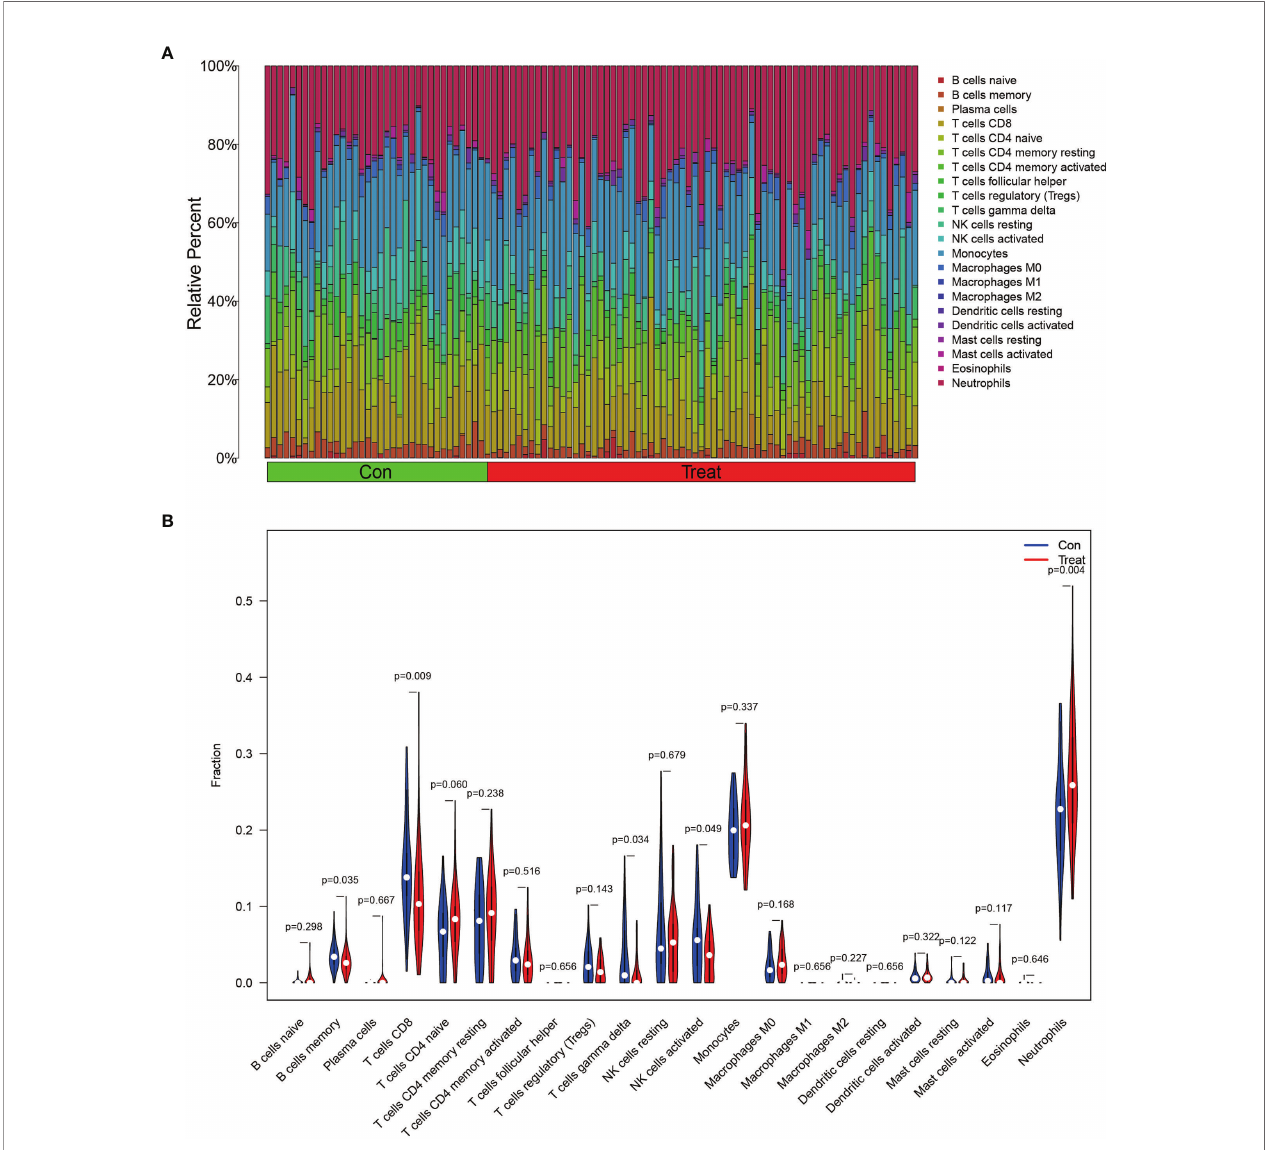
FIGURE 6 | Immune cell composition analysis and differential expression analysis of immune cells. (A) shows the immune cell composition of all GEO downloaded samples, each sample consists of 22 immune cells with a total ratio of 100%. (B) shows the differences in immune cells in AS and control group, as seen in Neutrophils, NK cells activated, T cells gamma delta, T cells CD8 and B cells memory were signi fi cantly different (p <